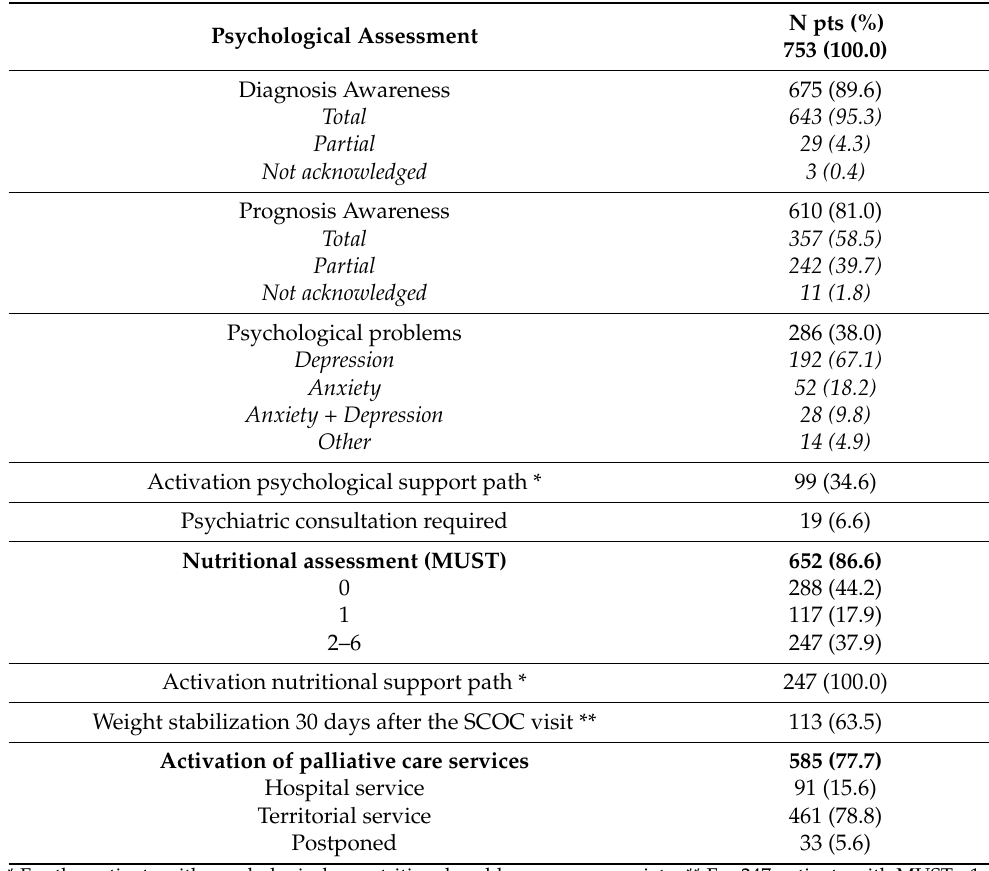
Table 6. Output of SCOC visit.